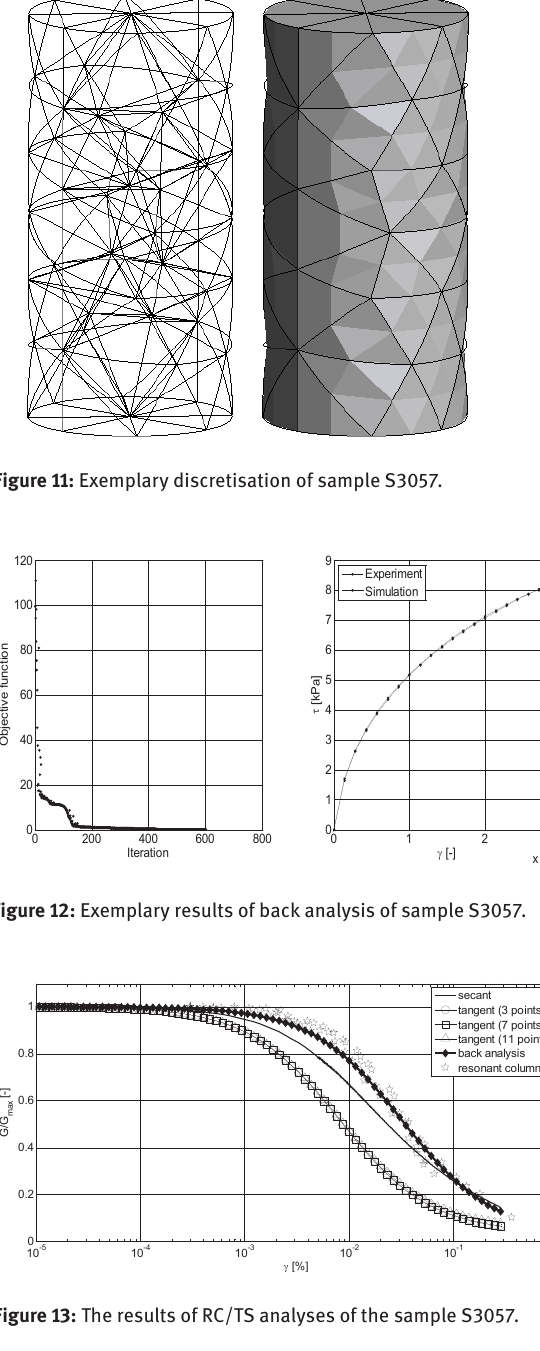
Fig. 14. The results of RC/TS analyses of the sample S5919.